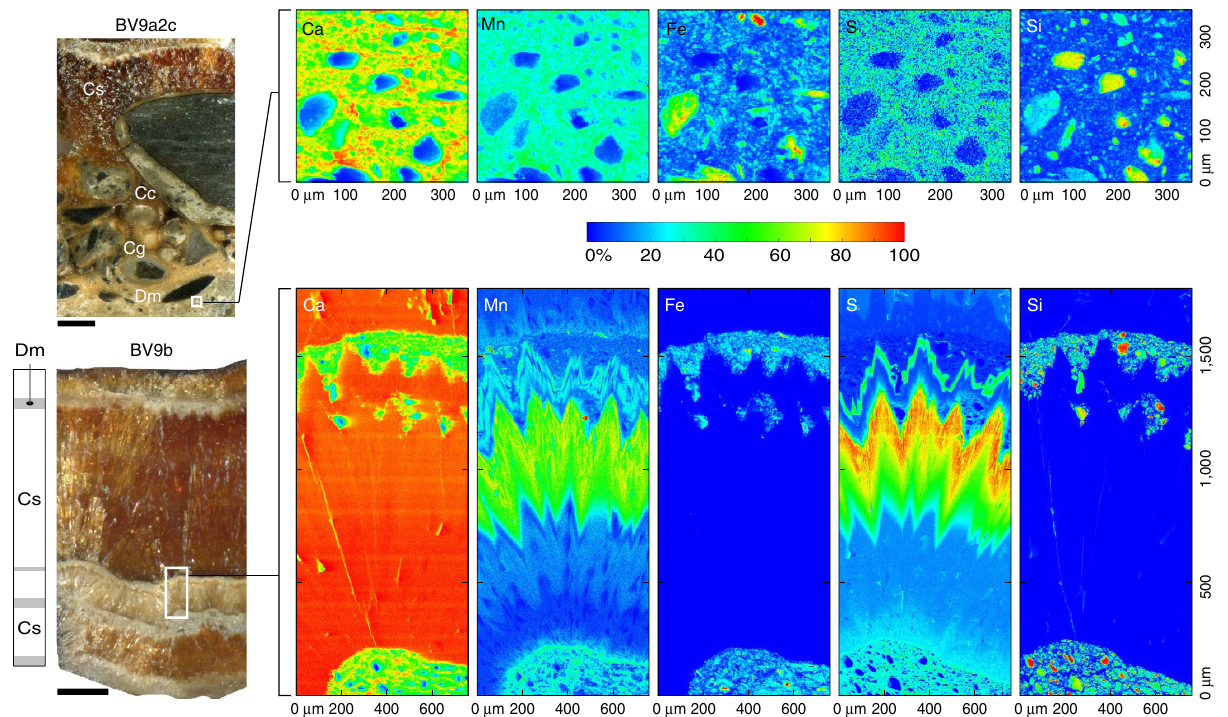
Figure 2 | Boggs Valley subglacial calcites petrography and elemental concentration. Sample BV9a2c is representative of deposits found in furrows consisting of rounded clasts cemented by isopachous calcite rims (Cc), granules coated by micrite (Cg: coated grains) capped by columnar Cs. Synchrotron micro XRF elemental maps for the area designated by a white box highlight that maximum concentration of S (as sulfate) is in the calcite matrix. Fe reaches up to 22,000p.p.m. (as determined by laser ablation (LA)-ICP-MS) in particulate, and it is likely present in the form of oxy-hydroxides when not associated with Si-rich particles. The polished thick section of BV9b is typical of Boggs Valley calcites consisting predominantly of Cs, interrupted by thin layers of Dm, as shown in the microstratigraphic log to the left. The elemental maps for the area designated by a white box show S concentration increasing toward the contact with the overlying Dm. Mn distribution is similar to S and can be interpreted as reflecting a common source or an increase in temperature, as Mn incorporation in calcite is temperature dependent 59 . In the clean Cs, Fe concentration is below 200p.p.m., with Fe distribution appearing blue on the colour scale. Note that S and Mn concentration distributions follow crystal terminations, providing robust evidence for preservation of environmental signals in Boggs Valley calcites. Scale bar for both BV9a2c and BV9b polished sections is 5mm. In all maps, elements are reported in normalized counts ranging from high (red) to low (blue) relative concentration according to the 0–100% scale